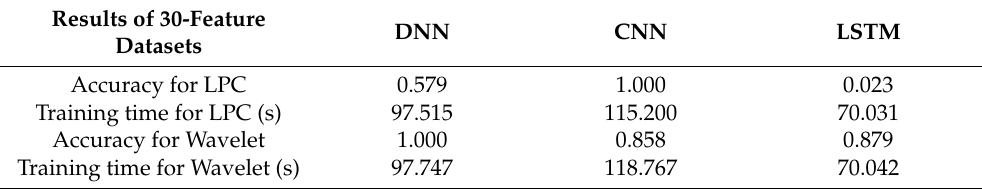
Table 2. Results with three deep learning structures of 30-feature datasets.